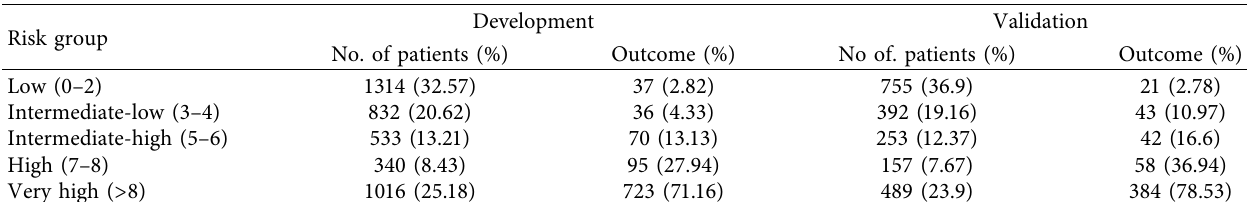
Table 3: Proportion of patients who experienced the study outcome (death or hypoxaemia) segregated by risk